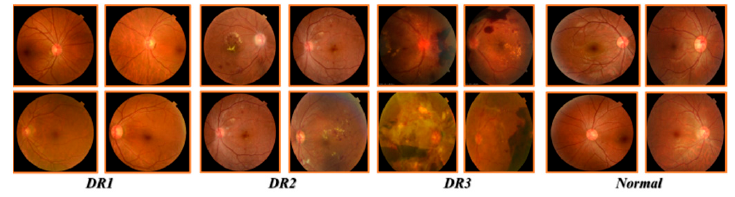
Figure 3. Fundus image database.